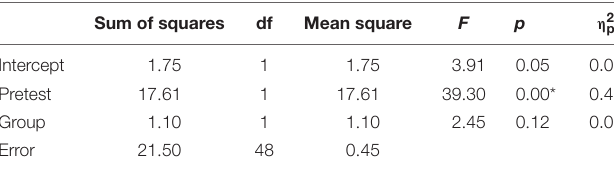
TABLE 5 | One-way ANCOVA on self-efficacy in learning English between two groups. Sum of squares